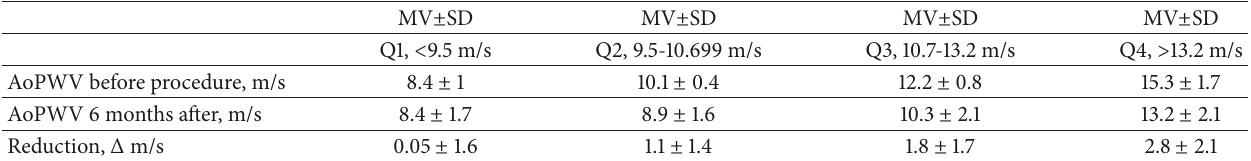
Table 3: Effects of the baseline pulse wave velocity on pulse wave velocity changes after 6 months.